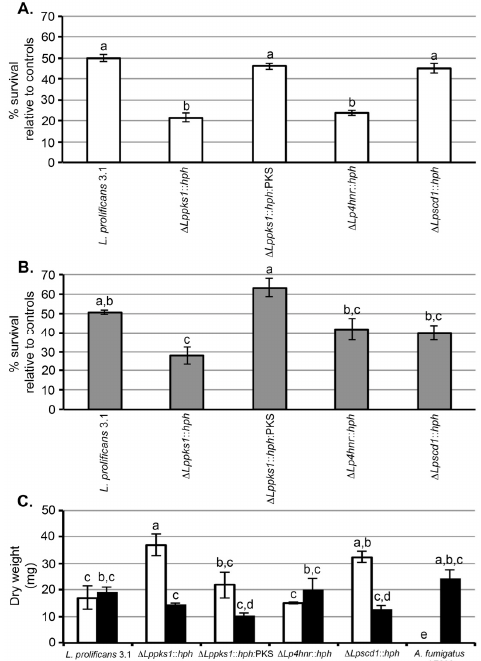
Figure 3. Sensitivities of L. prolificans 3.1 and melanin mutants to UV, H 2 O 2 and the antifungal drug amphotericin B. ( A ) Sensitivities of spores to oxidative killing by H 2 O 2 . Spores were exposed to 160 mM H 2 O 2 or phosphate buffer only (control) for 60 min and then plated onto SDA. After incubation in the dark for 3 day at 30 °C, the number of colonies derived from germinated spores were counted and the % survival for each strain determined relative to matched controls (untreated spores). Each bar is the mean of 3 replicates ± standard error and bars with similar letters indicate that differences in means are not statistically significant at p < 0.05 (ANOVA). Under these conditions, ~50% of treated spores of the wild-type strain 3.1 survived compared to matched control spores. Compared to strain 3.1, there was a significant reduction in % survival of mutants Δ Lppks1 :: hph and Δ Lp4hnr :: hph due to exposure to H 2 O 2 . There was no significant effect of H 2 O 2 on the survival of mutant Δ Lpscd1 :: hph or on the survival of Δ Lppks1 :: hph :PKS compared to 3.1, showing that complementation of mutant Δ Lppks1 :: hph had restored spore survival to wild-type levels; ( B ) Sensitivities of spores to UV light. Spores were exposed to a UV dose of 200 mJ/cm 2 and then plated onto SDA. After incubation in the dark for 3 days at 30 °C, the number of colonies derived from germinated spores were counted and the % survival for each strain determined relative to matched controls (untreated spores). Each bar is the mean of 3 replicates ± standard error and bars with similar letters indicate that differences in means are not statistically significant at p < 0.05 (ANOVA). Under these conditions, ~50% of treated spores of the wild-type strain 3.1 survived compared to matched control spores. Compared to strain 3.1, there was a significant reduction in % survival of mutant Δ Lppks1 :: hph due to exposure to UV. There was no significant effect of UV exposure on the survival of mutants Δ Lpscd1 :: hph and Δ Lp4hnr :: hph . Similarly, there was no significant difference in the % survival of Δ Lppks1 :: hph :PKS spores compared to 3.1, showing that complementation of mutant Δ Lppks1 :: hph had restored spore survival to wild-type levels; ( C ) Sensitivities of strains to the polyene antifungal drug amphotericin B. Each bar is the mean of 3 replicates ± standard error and bars with similar letters indicate that differences in means are not statistically significant at p < 0.05 (ANOVA). The black bars are the controls lacking amphotericin B and the open bars show growth in the presence of the drug. Growth (dry weight in mg) of the drug-resistant wild-type strain 3.1 and mutant Δ Lp4hnr1 :: hph was unaffected by the drug. Similarly, there was no significant difference in the growth of the complemented strain Δ Lppks1 :: hph :PKS in the presence and absence of the drug, showing that restoration of melanin biosynthesis re-established drug insensitivity of the fungus to wild-type levels. In contrast, significant increases in growth were found in the albino mutant Δ Lppks1 :: hph and mutant Δ Lpscd1 :: hph in the presence of the drug, while the drug completely inhibited growth of the control pathogen Aspergillus fumigatus.